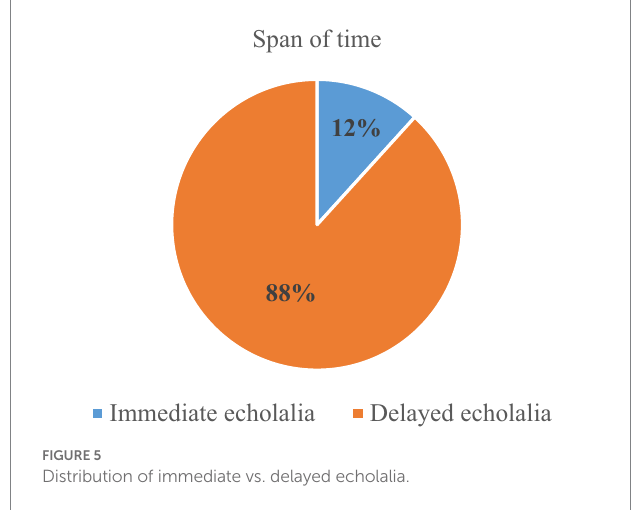
FIGURE 7 Distribution of the sources of